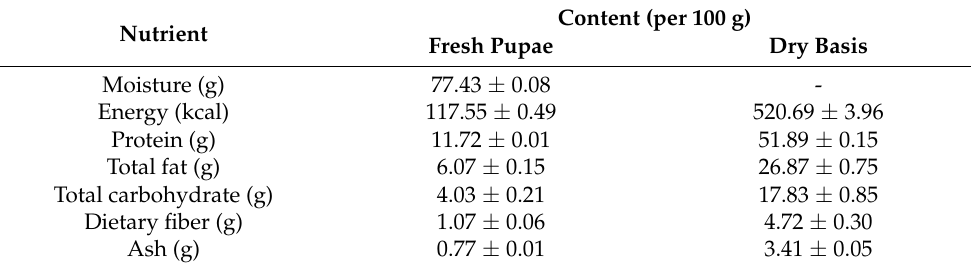
Table 1. The nutrient composition of silkworm